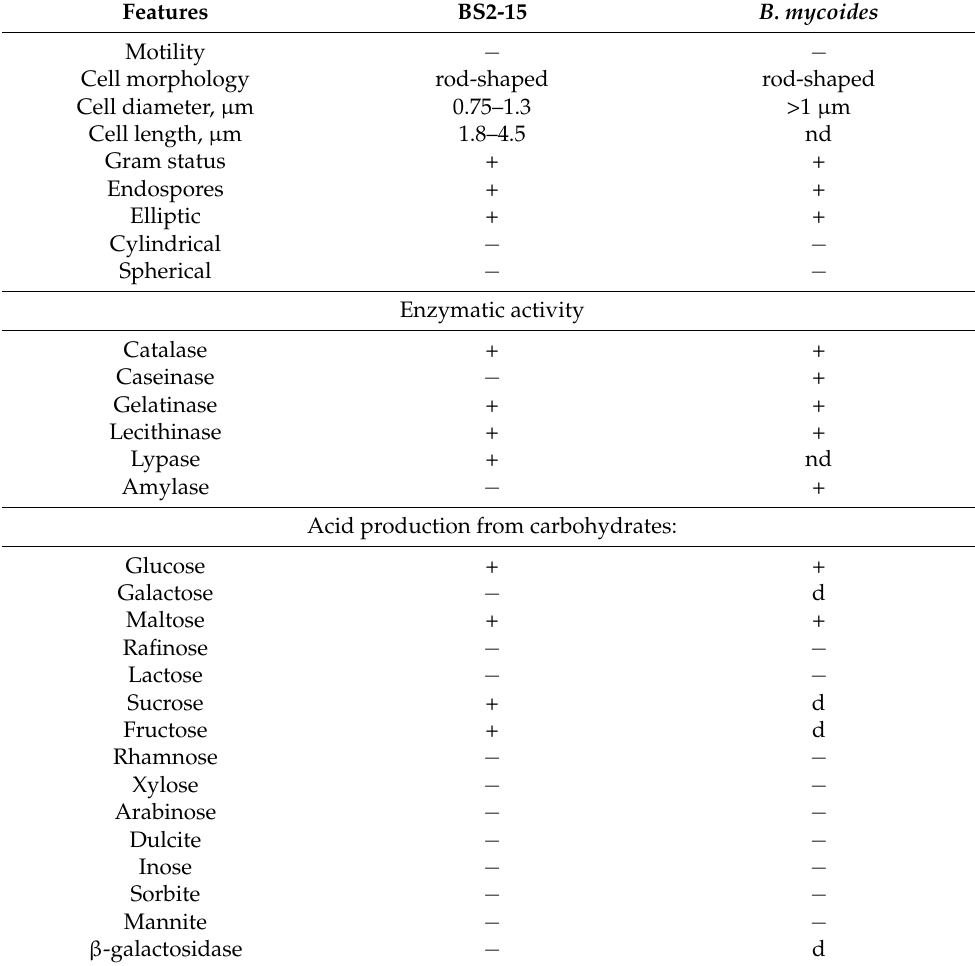
Table 1. Morphological and biochemical features of strain